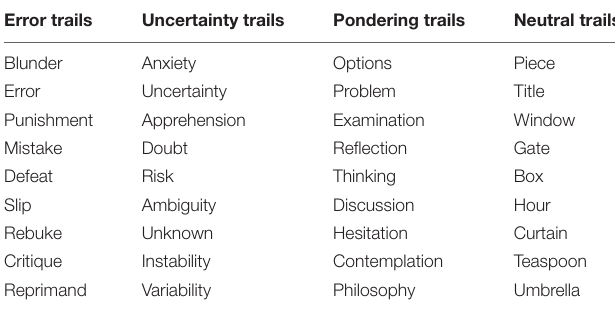
TABLE 1 | Words used in the emotional Stroop task